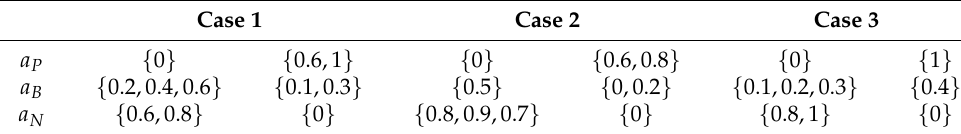
Table 6. The values of loss function for three cases.